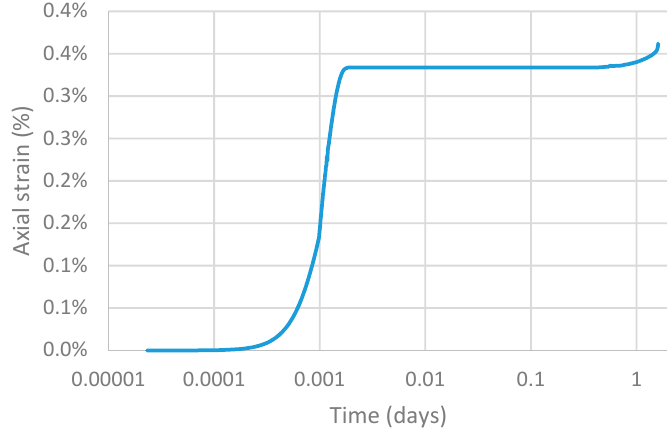
Figure 9. Simulation of uniaxial creep test.